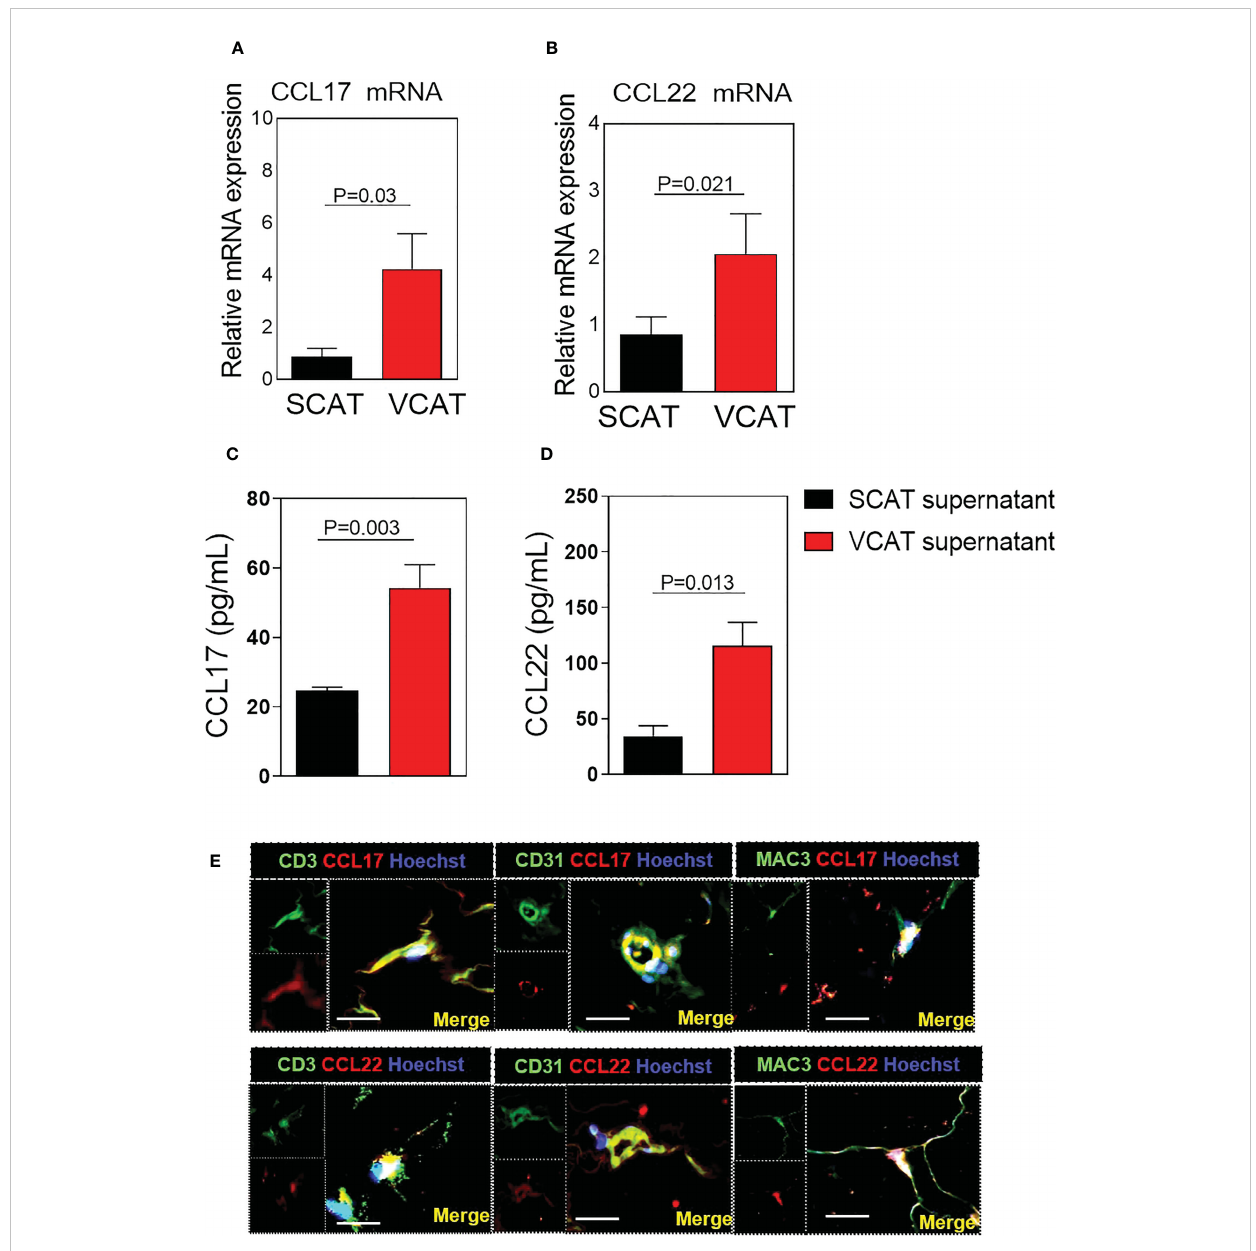
FIGURE 2 Expression of CCL17 and CCL22 is increased in VCAT from morbidly obese patients. Relative quanti fi cation of mRNA levels for (A) CCL17 and (B) CCL22. Comparisons between groups were made by Wilcoxon matched-pair signed-rank test. Values are expressed as mean ± SEM (n = 33). (C) CCL17 and (D) CCL22 chemokine release into conditioned media was determined after 48 h of SCAT and VCAT explant culture. Chemokine secretion is expressed as pg/ml in the supernatant. Values are expressed as mean ± SEM (n = 22). Comparison between groups were made by Mann Whitney test. (E) Immuno fl uorescence representative images showing colocalization of CCL17 with CD3 (lymphocytes), CD31 (endothelial cells) and Mac-3 (macrophages); or CCL22 with CD3, CD31, Mac-3 in VCAT. Immunoreactivity was visualized using Alexa Fluor 594 (CCL17 and CCL22, red ) and Alexa Fluor 488 (CD31, CD3, Mac-3, green ) secondary antibodies. Nuclei were stained with Hoechst ( blue ). Scale bar, 20 m m. Nuclei were stained with Hoechst ( blue